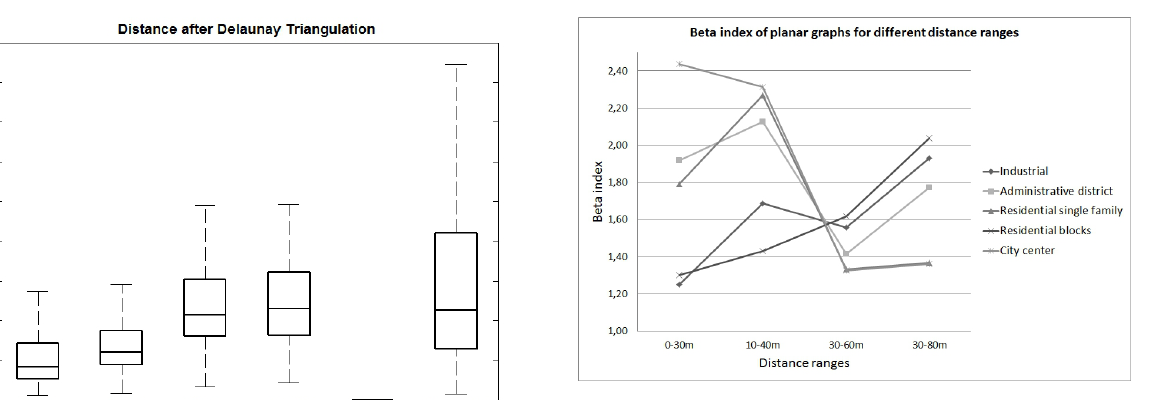
Figure 5: Beta index of planar graphs for different distance ranges tance ranges. Residential single family houses and residential block building graphs appeared to have assortative behavior in the lower distant range (Figure 6).